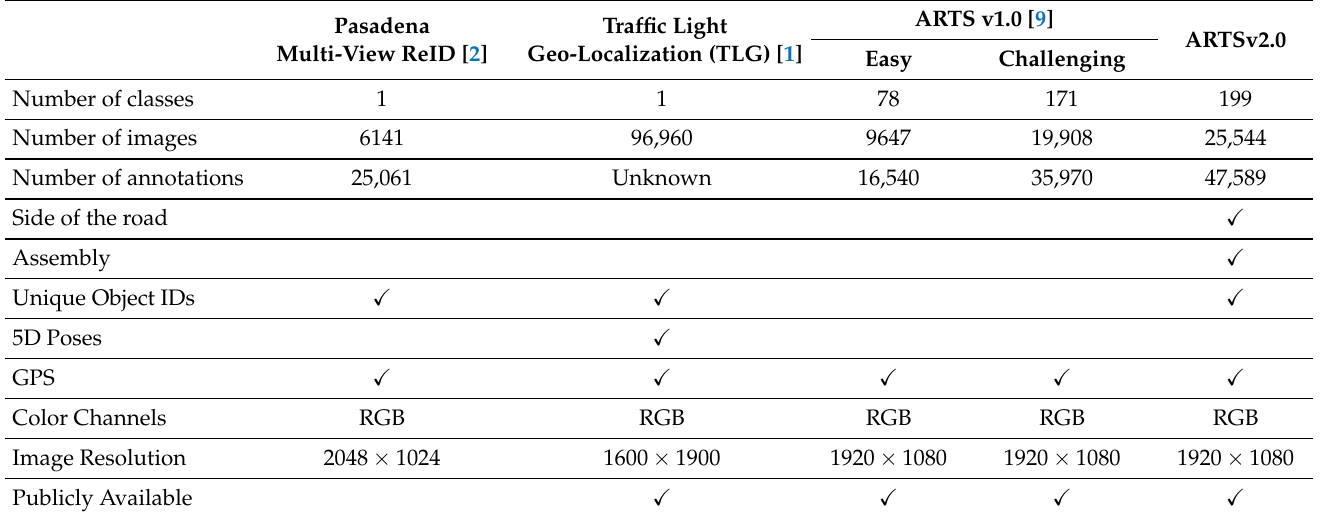
Table 1. A comparison between the Pasadena multi-view object re-identification [2], the traffic light geo-localization (TLG) [1], ARTS v1.0 easy and challenging [9], and ARTSv2.0 datasets. Pasadena Traffic Light Multi-View ReID [2] Geo-Localization (TLG)